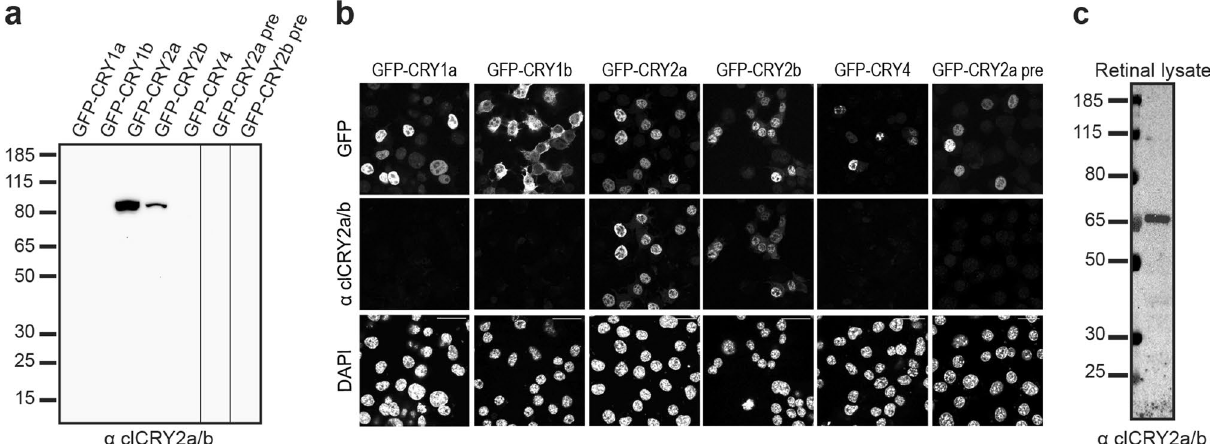
Figure 2. Generation and validation of clCRY2a/b monoclonal antibody. An antibody against the C-terminal (C516-V583) of clCRY2a/b was generated in mice. ( a ) Western blot of pigeon embryonic fibroblast (PEF) cell lysates overexpressing GFP-tagged clCRY1a, clCRY1b, clCRY2a, clCRY2b and clCRY4 incubated with α clCRY2a/b 2A3 reveals specific recognition of both clCRY2a and clCRY2b. No cross reactivity between the other cryptochromes was observed. Preincubation of the antigen with the antibody abolished any visible signal. ( b ) Immunostaining of α clCRY2a/b on GFP-tagged recombinant clCRYs expressed in N2A cells shows specific clCRY2a/b signal, as observed in western blots ( a ). ( c ) Western blot of purified α clCRY2a/b on pigeon retinal lysates confirms specificity, with recognition of a single ~ 67kDA band. Scale bar: 20 µm. See Fig. S2